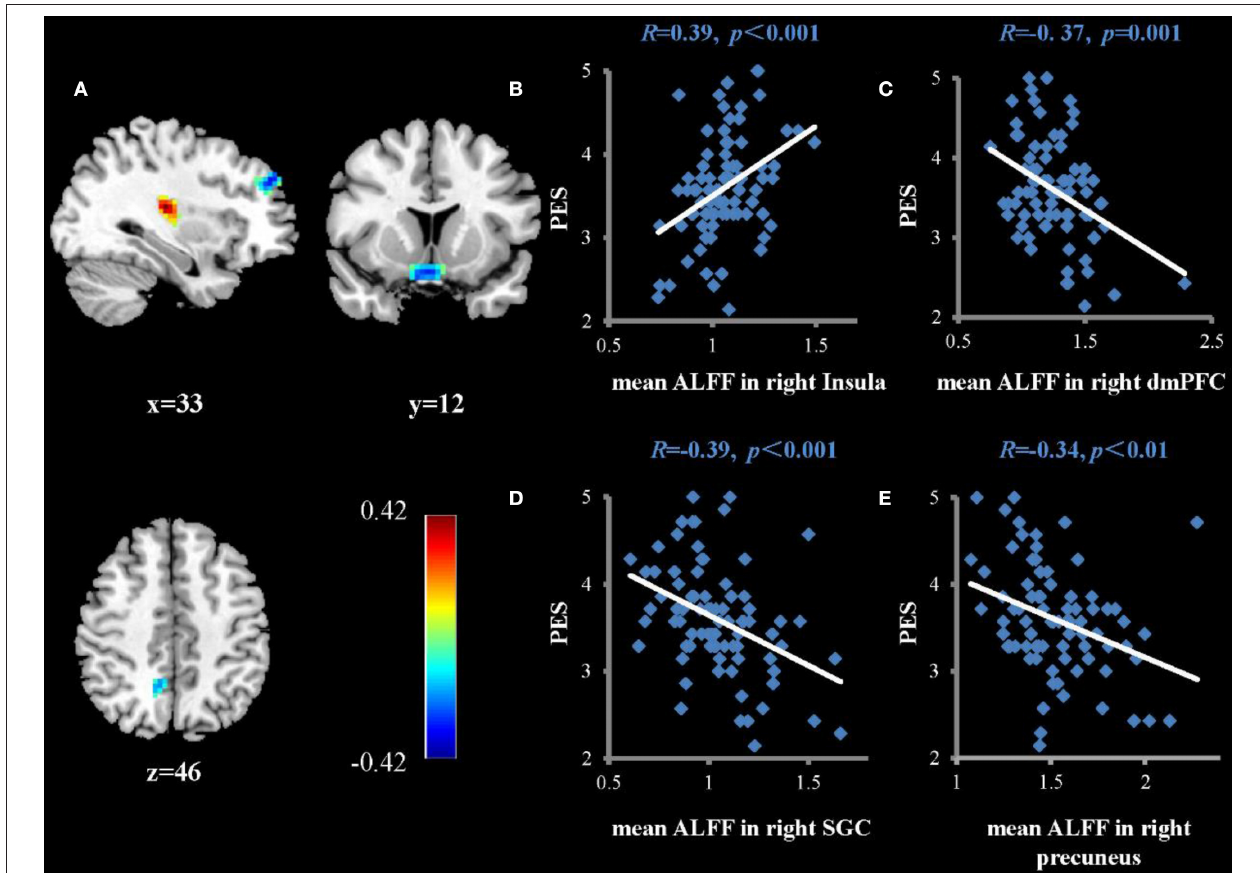
FIGURE 1 | Brain regions that show significant correlations between ALFFs and the average score of PES (A) (multiple regressions, P < 0.05, AlphaSim-corrected). Color bars represent R-values. L = left, R = right. (B–E) show scatterplots of the correlations between PES score and mean ALFFs in the right insula, dorsomedial prefrontal cortex (dmPFC), subgenual cingulate (SGC), and right precuneus, respectively.